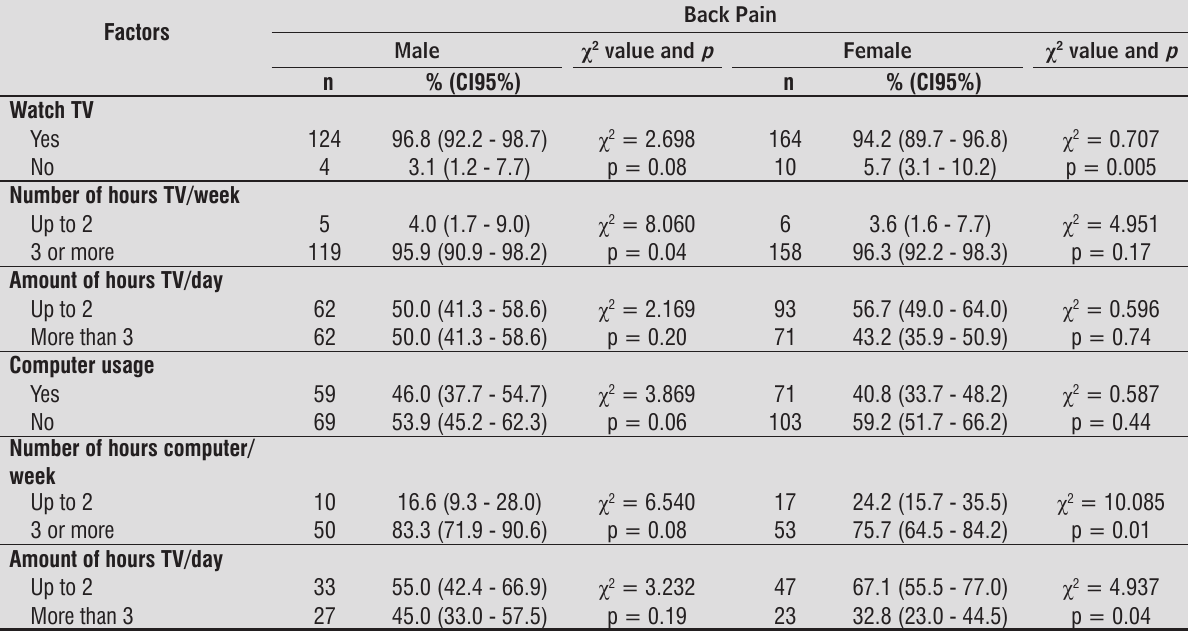
Table 3 - Bivariate analysis between back pain and sedentary activities of the sample with subjects over 20 years old, liv- ing in the city of Bauru (São Paulo, Brazil), by gender Factors